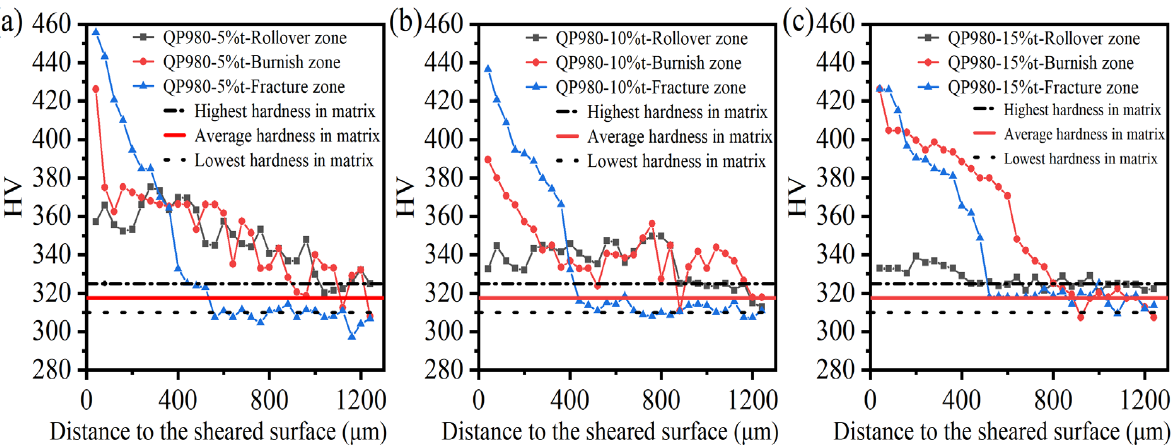
Figure 21. Microhardness distribution of sheared edge under different shearing clearances. ( a ) 5%t, ( b ) 10%t, ( c ) 15%t.